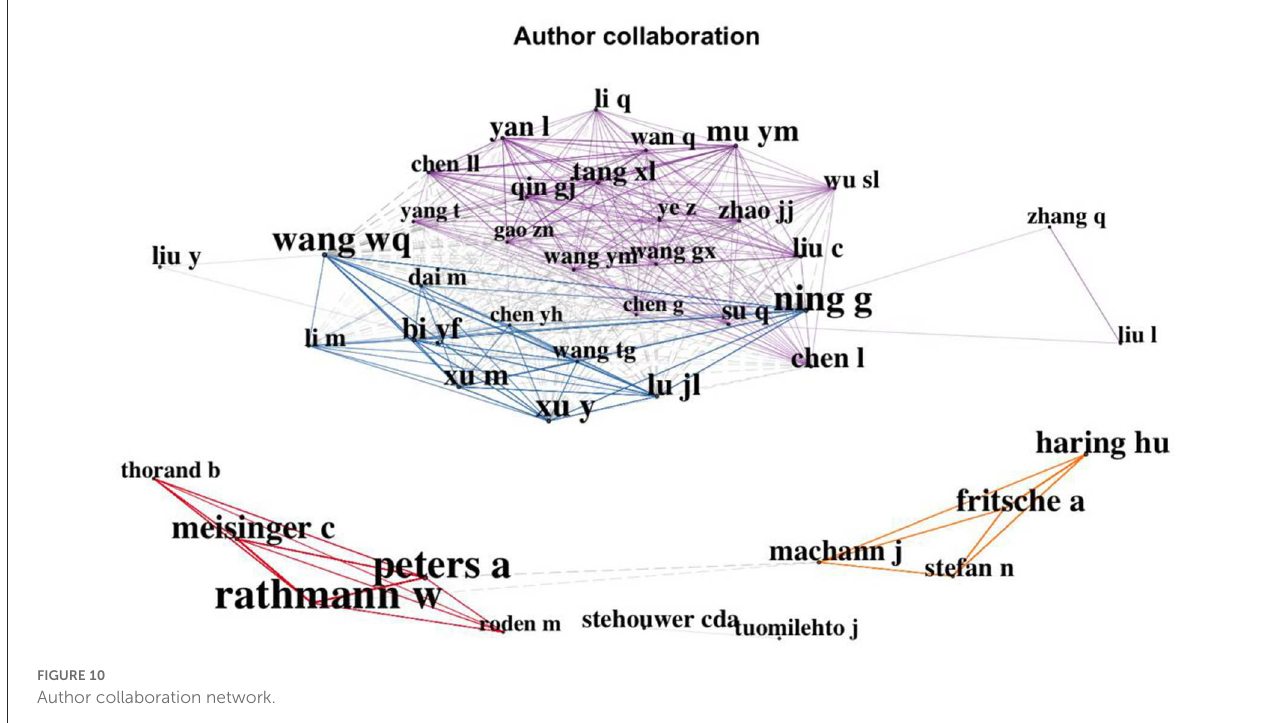
FIGURE10 Author collaboration network.